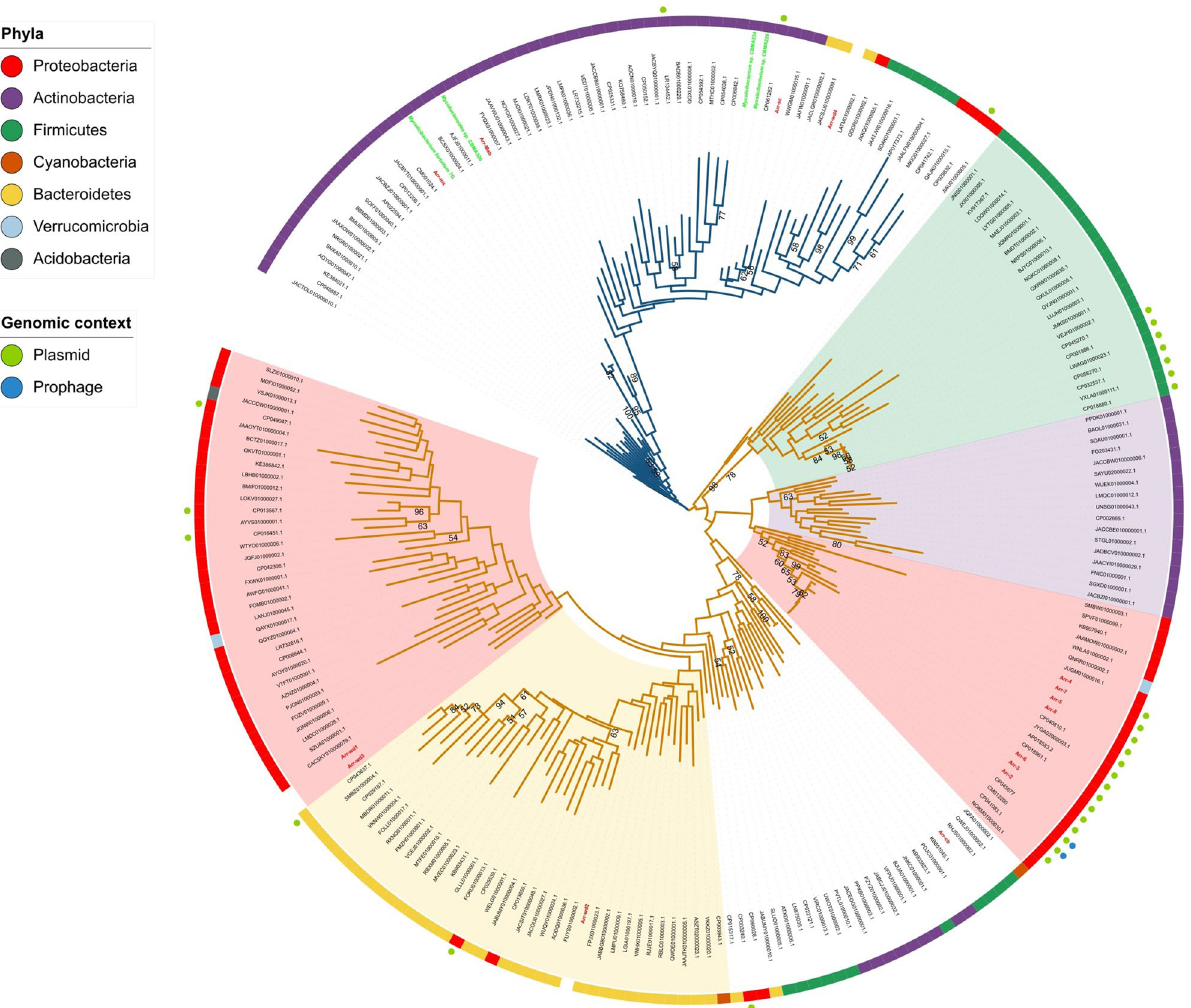
Figure 2. Arr phylogeny generated by the maximum likelihood method. The blue (clade I) and yellow (clade II) branches denote the two main clades. Some sub-clades of clade II are highlighted. Arr sequences functionally verified by this study and other studies are labeled green and red, respectively. Bootstrap values above 50 are shown. The outer color strips indicate the bacterial phylum of the sequence. The presence of colored circles beside the strips indicates whether the sequence has been identified in a mobile element. Reference sequences are ticked in red and have been functionally characterized.